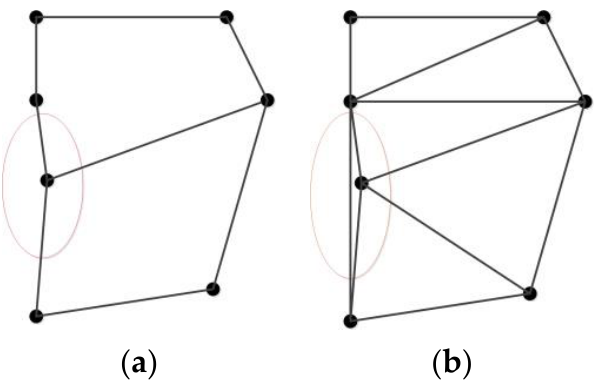
Figure 4. Illustration of CDT by using nodes and segments. ( a ) Concave border road and ( b ) long narrow triangle.